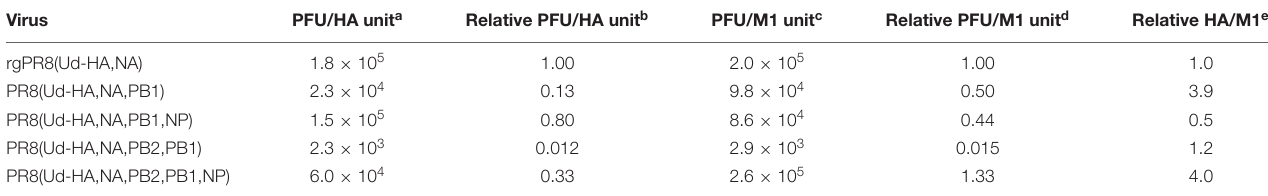
TABLE 1 | Amount of infectious virus required to achieve an equivalent level of HA or M1 staining and relative abundance of HA per virion. Virus